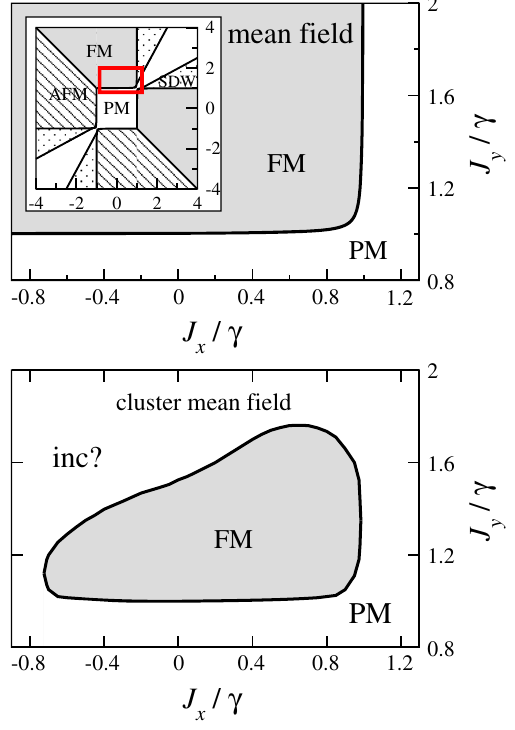
FIG. 1. A sketch of the phase diagram of the model defined by Eqs. (2) and (3), for J z ¼ 1 . The single-site mean field as worked out in Ref. [19] would predict the emergence of different phases: paramagnetic (PM), ferromagnetic (FM), antiferromagnetic (AFM), and spin-density-wave (SDW) phases (inset to the top panel). Here, we focus on the region highlighted by the red box, which displays a transition from PM to FM states (magnified in the top panel). A proper inclusion of short-range correlations (through the cluster mean field) shrinks the ferromagnetic region to a small “ island, ” thus suppressing the order at large couplings and hinting at a possible incom- mensurate (inc) ordering (bottom